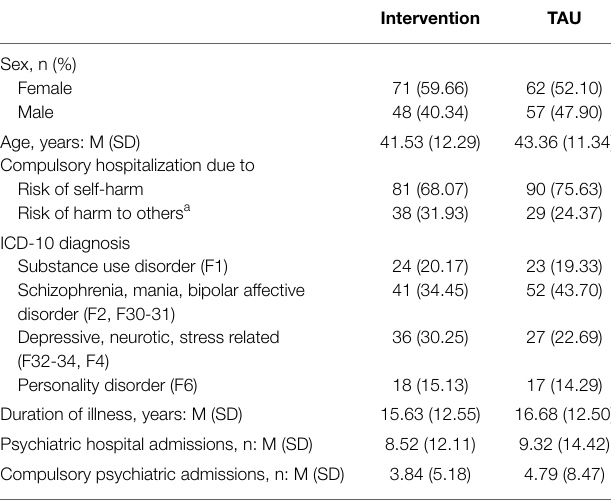
TABLE 1 | Baseline sample characteristics